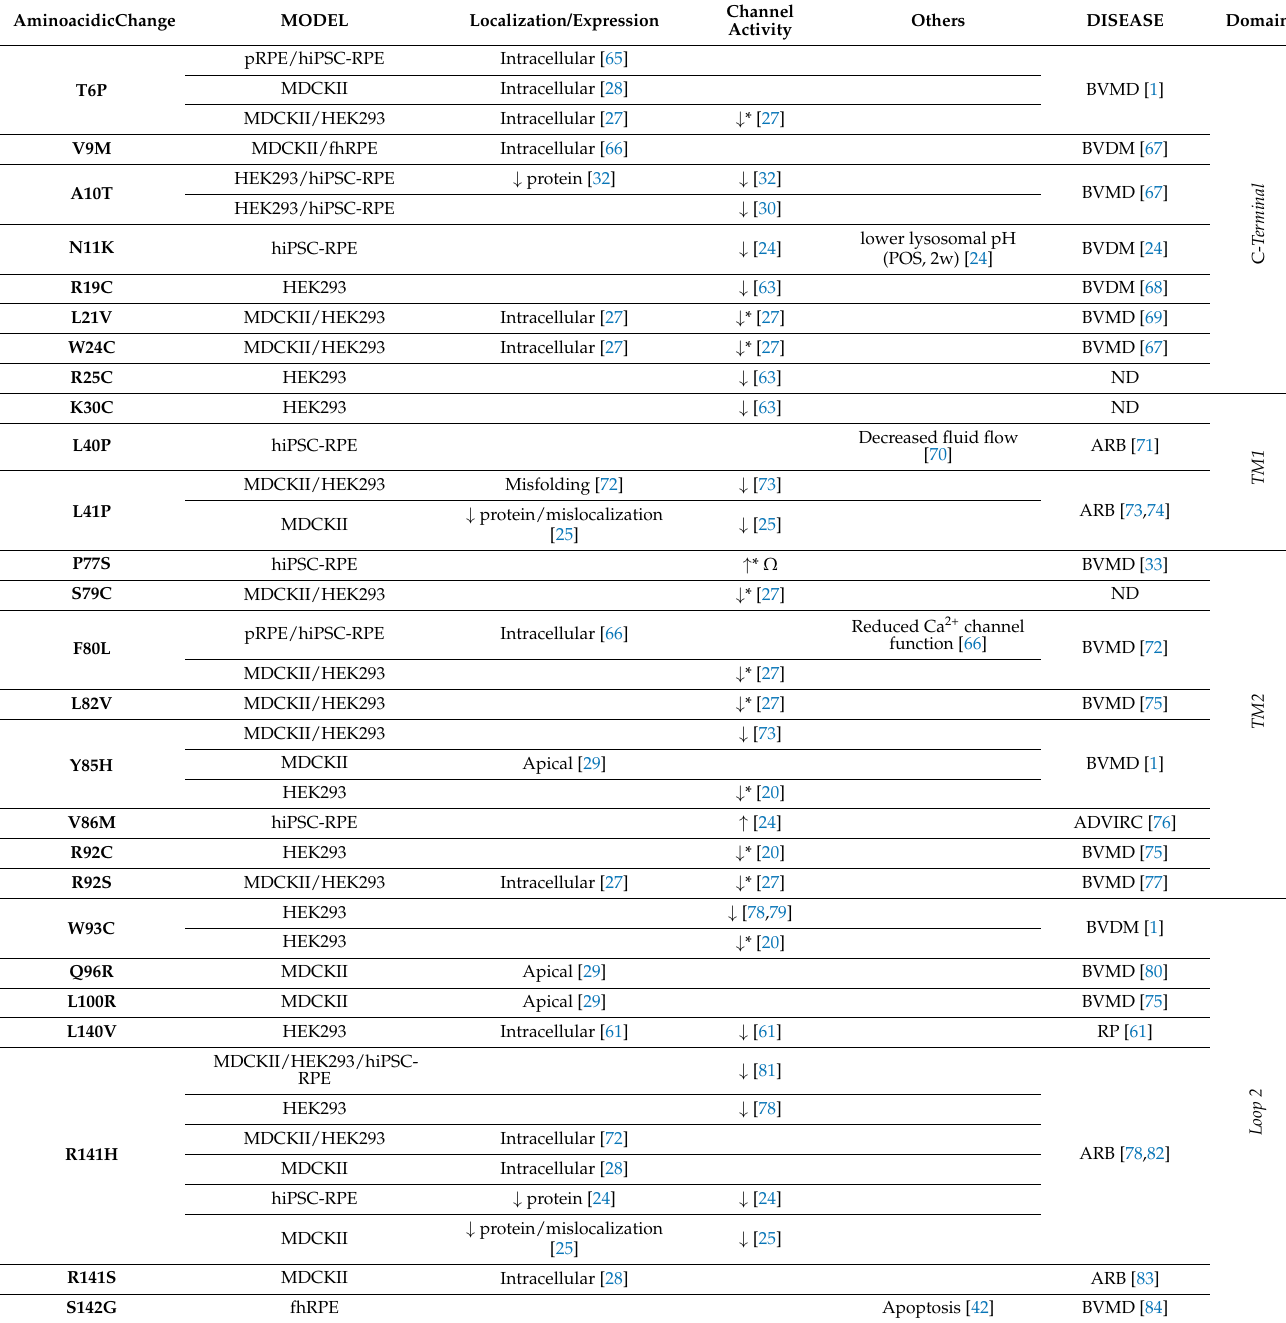
Table 1. List of BEST1 aminoacidic changes functionally characterized in cellular models. Each functional characterization describes and references the cellular model in which the experiments were performed, and the phenotype observed ( ↓ = decreased, ↑ = increased). The associated disease is described and referenced for each aminoacidic change as well as the specific zone where the mutation is found. (pRPE = porcine RPE, fhRPE = fetal human RPE, POS = Photoreceptor Outer Segments, ND = Not Described, Ω = variant described in this manuscript). Asterisks (*) indicate anion conductance determined by YFP chloride sensors instead of patch clamp